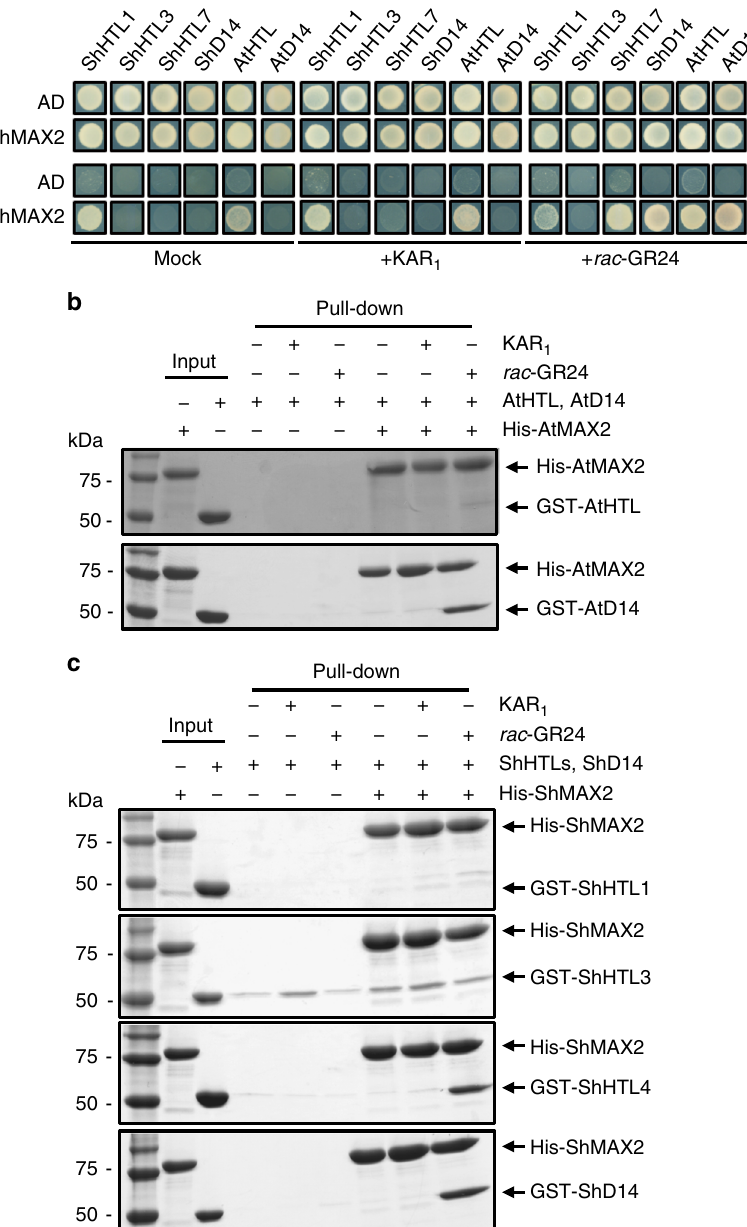
Fig. 5 Interactions between HTLs/D14s and MAX2. a Interactions between HTL/D14 and ShMAX2, as determined by Y2H assays. Yeast cells were co- transformed with binding domain (BD)-fused ShHTL1, ShHTL3, ShHTL7, ShD14, AtHTL, or AtD14 and activation domain (AD)-fused ShMAX2. Interactions between bait and prey were detected in the absence or presence of 5 μ M KAR 1 or 5 μ M rac -GR24 in the control medium (SD/ − Leu/ − Trp; − LT) and the selective medium (SD/ − Leu/ − Trp/ − His/ − Ade; − LTHA). b Interactions between AtHTL or AtD14 and AtMAX2 according to the in vitro pull-down assays (detected by Coomassie Brilliant Blue (CBB) staining). His 6 -tag-fused AtMAX2 was used as bait and AtHTL and AtD14 with GST-tags were used as prey. c Interactions between HTL/D14 and ShMAX2, as determined by the in vitro pull-down assays (detected by CBB staining). In vitro pull-down assays were performed using recombinant His 6 -tag-fused ShMAX2 as bait. ShHTL1, ShHTL3, ShHTL4, and ShD14 with GST-tags were used as prey. Interactions were tested with or without 50 μ M KAR 1 or 50 μ M rac -GR24. The full gels are shown in Supplementary Fig.